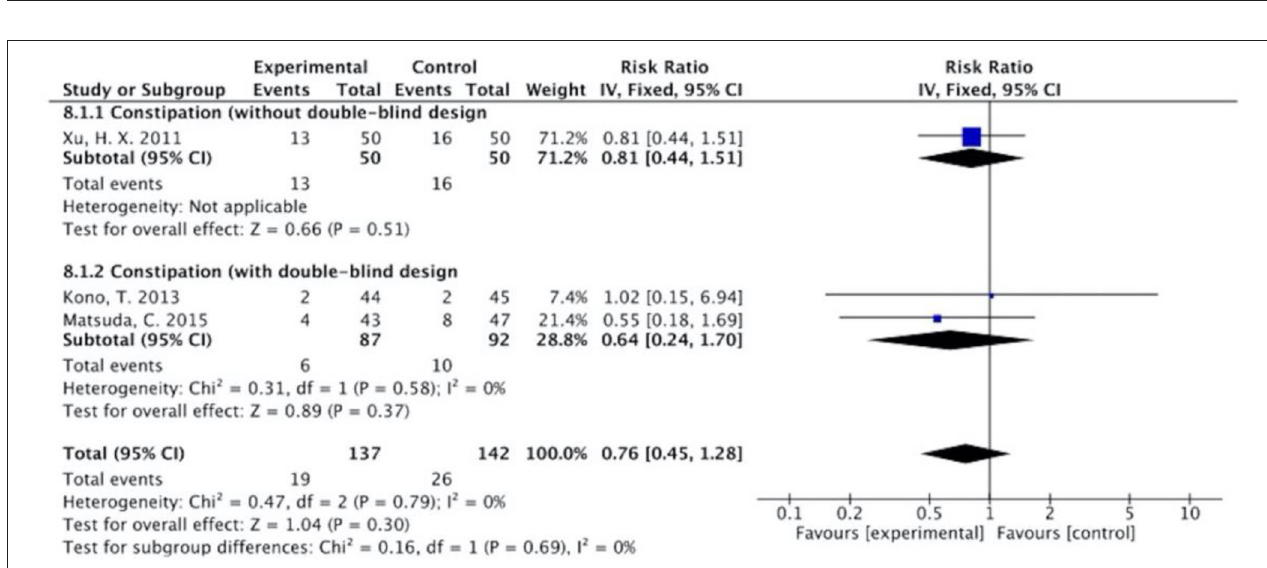
FIGURE 11 | Sub-analysis on the effect of herbal medicine in constipation in chemotherapy-induced toxicity.